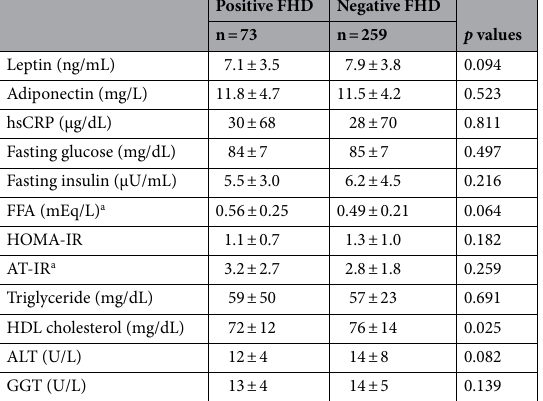
Table 4. Biochemical characteristics of young Japanese female athletes and non-athletes in the presence and absence of family history of type 2 diabetes (FHD). Mean ± SD. a n = 57 and 96 of positive and negative family history, respectively. ALT: alanine aminotransferase, GGT: γ-glutamyl transferase, other abbreviations are the same as in Table